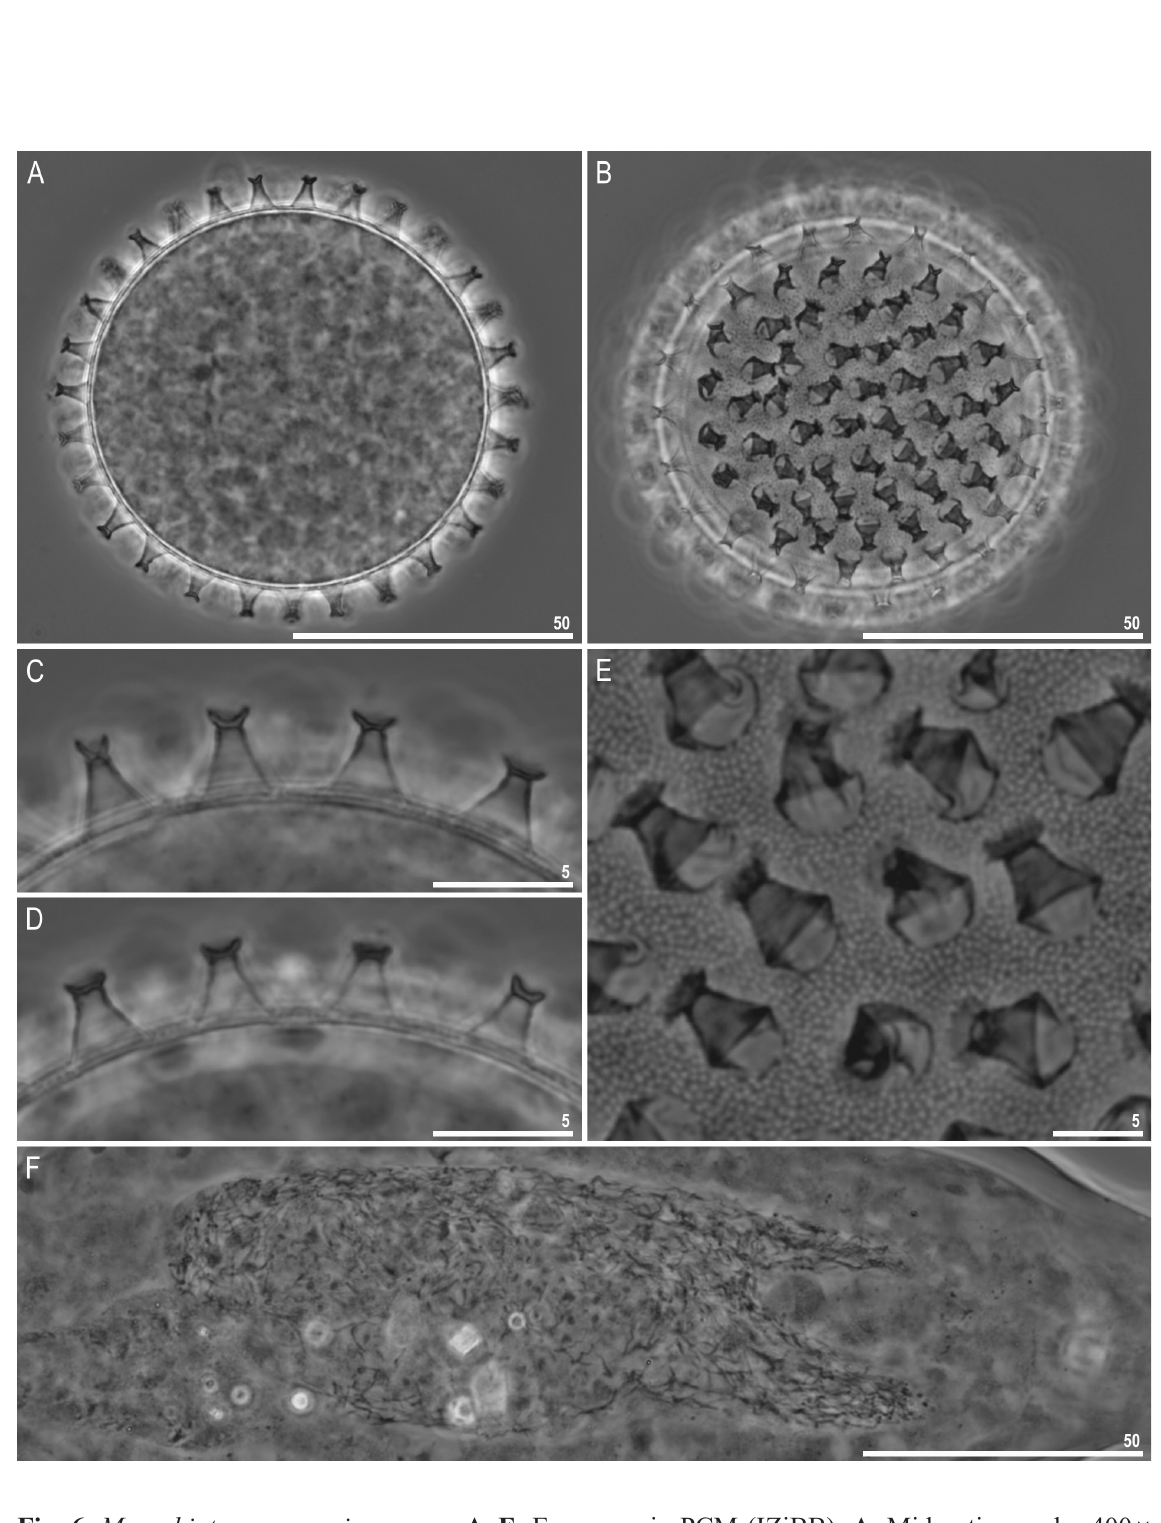
Fig. 6. Macrobiotus noongaris sp. nov. A–E . Egg, seen in PCM (IZiBB). A . Midsection under 400 × magnification. B . Surface under 400× magnification. C–D . Midsection under 1000 × magnification. E . Surface and terminal discs under 1000× magnification. F . Testis seen in PCM, with visible spermatozoa in male freshly mounted in Hoyer’s medium (paratype, IZiBB). Scale bars in